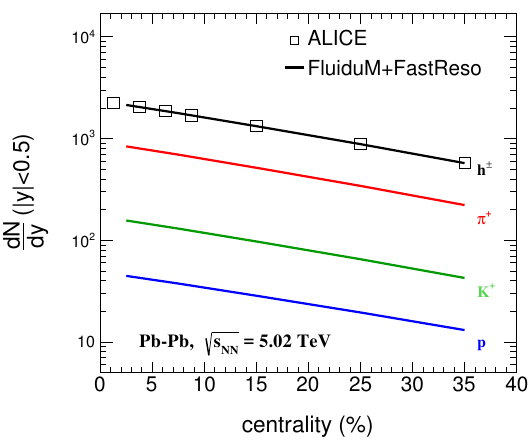
Figure 6 . Mid-rapidity densities dN/d y ( j y j < 0.5) of charged hadrons as functions of centrality in p Pb-Pb collisions at s NN = 5.02 TeV in comparison with the ALICE measurements [61]. Prediction for the mid-rapidity densities dN/d y ( j y j < 0.5) of pions, kaon and protons are also reported.